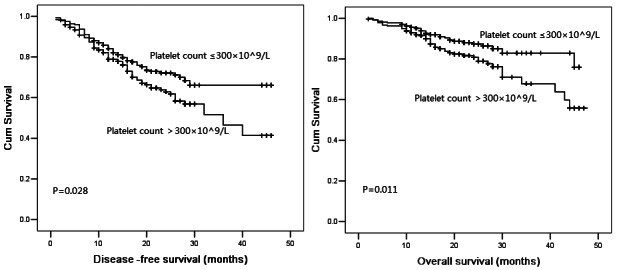
(A) Kaplan-Meier disease-free survival (DFS) curves and (B) overall survival (OS) curves according to platelet count; patients with normal platelet counts showed longer DFS and OS times.